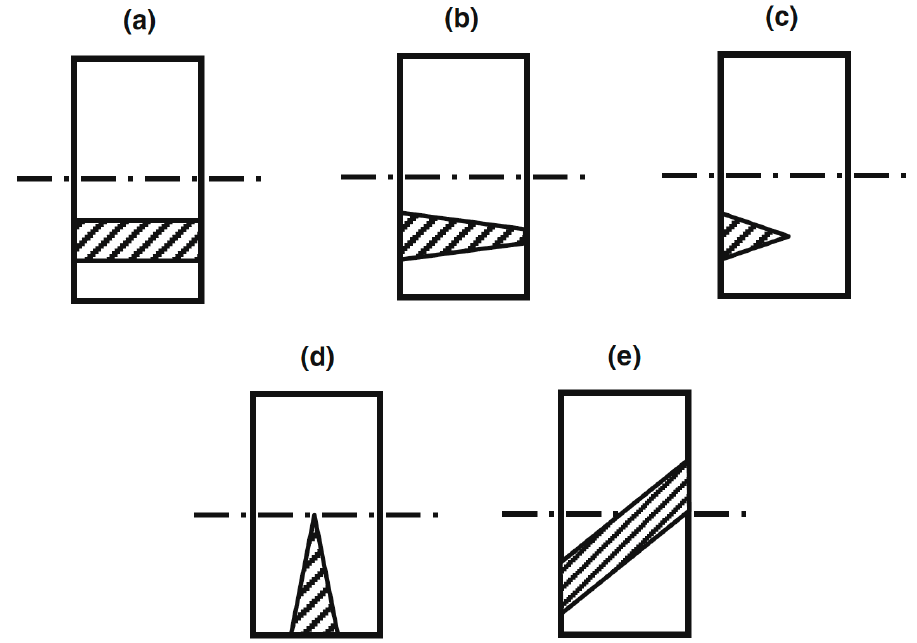
Figure 55. Schematic diagram showing the types of knots used in the parametric study: ( a ) cylindrical, ( b ) truncated conical, ( c ) shallow conical, ( d ) edge, and ( e ) inclined. From [178].